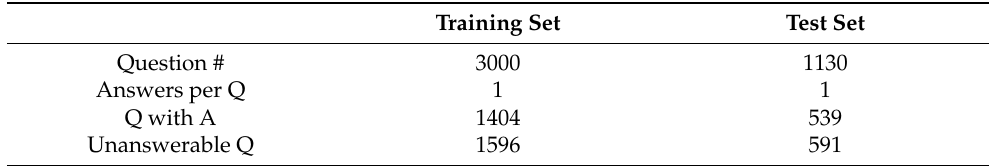
Table 2. Scale statistics of the DuReader-checklist